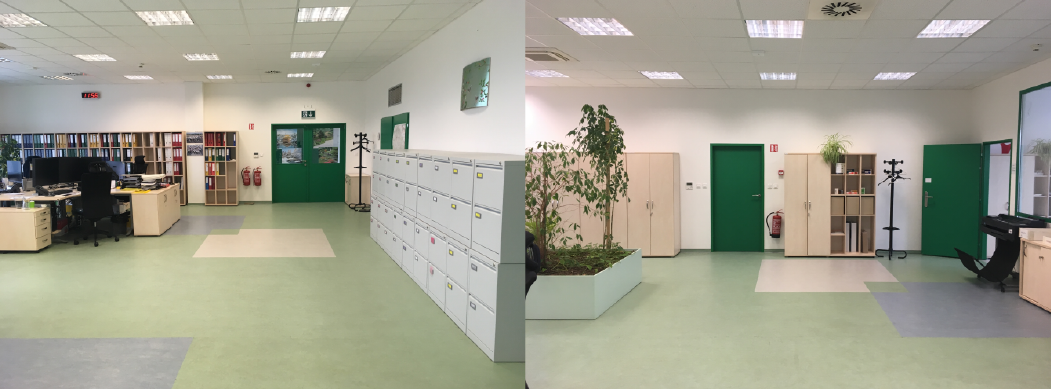
Figure 7. Tested view 1 (left image) and tested view 2 (right image) [39]